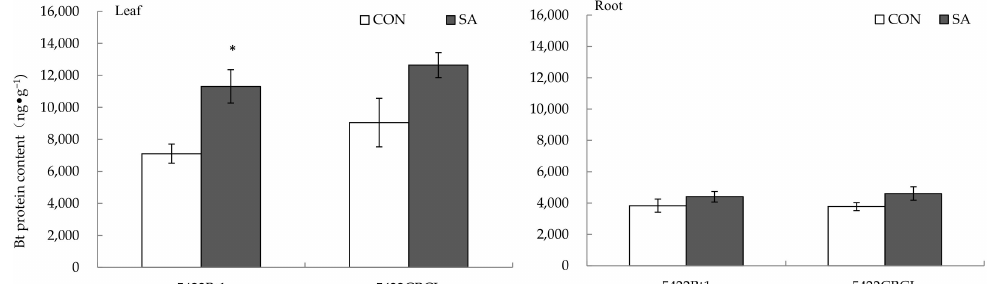
Figure 1. Direct and systemic effects of exogenous salicylic acid application to the aboveground part on the content of Bt protein in the leaves and roots of the Bt corns. The data in the figure are means ± standard errors. Significance among the data was determined by paired Student’s t -test. “*” showed p < 0.05. CON: control; SA: salicylic acid.